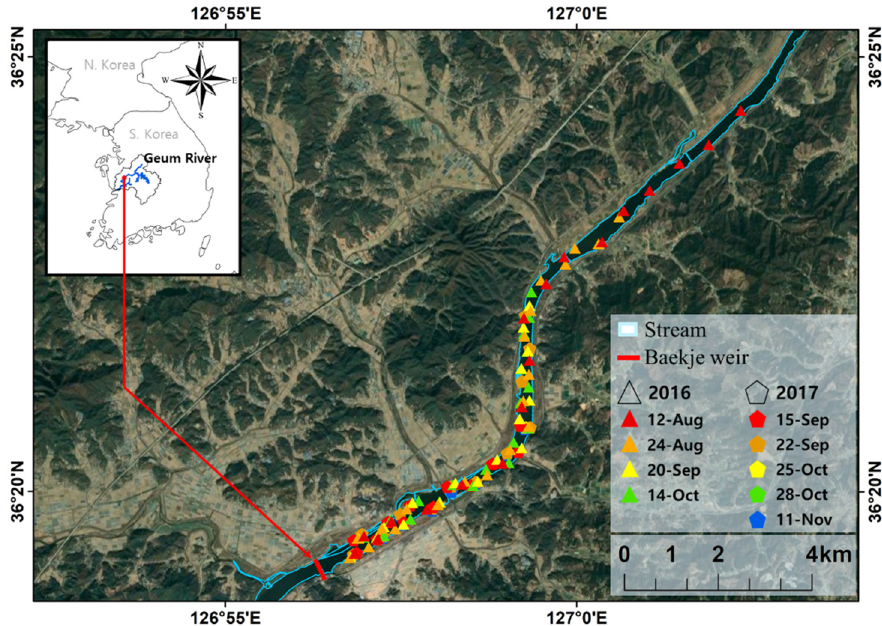
Figure 1. Map of airborne hyperspectral scanning area, Location of Baekje weir and monitoring points indicated, respectively, by red line and marks (2016: triangles; 2017: pentagons).